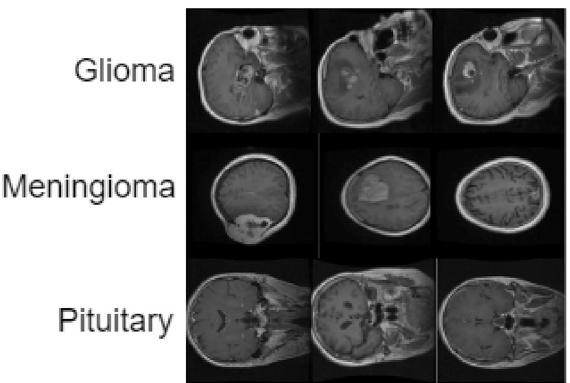
Figure 1. Sample images in brain tumor dataset 34 where each row represents images of same